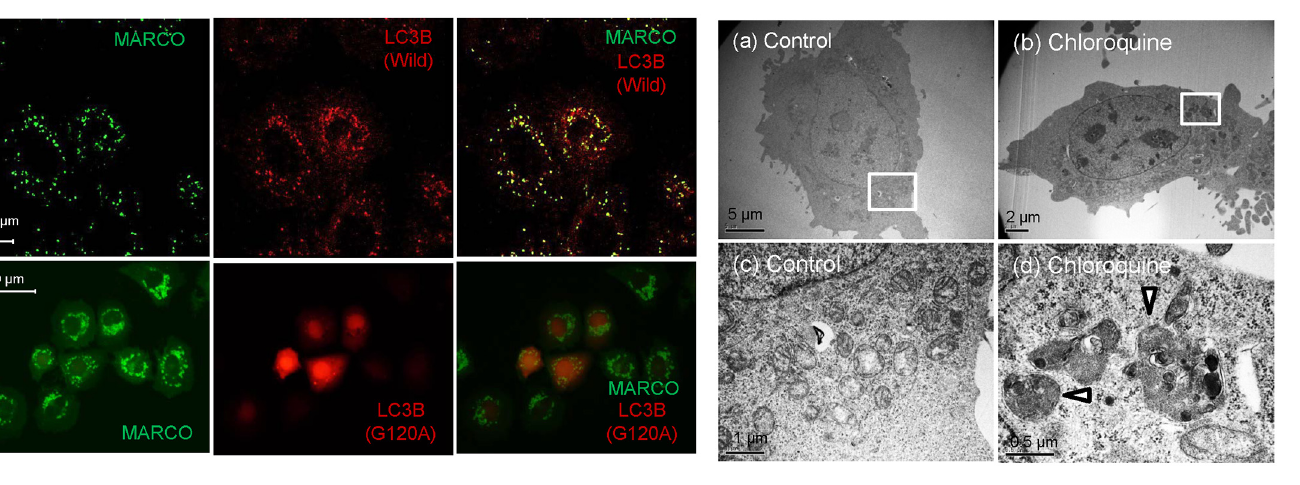
Fig 3. Effects of chloroquine on fluorescent puncta formation in GFP-MARCO-CHO cells. (A) Co-localization of green fluorescent puncta with LC3B. GFP-MARCO-CHO cells were transfected with constructs encoding LC3B (wild-type or G120A mutant), pre-cultured overnight in F12 complete medium, and further cultured for 16 hr in F12 complete medium supplemented with 50 μ M chloroquine. (B) Transmission electron micrographs of GFP- MARCO-CHO cells. The cells were cultured for 6 hr with (b, d) or without (a, c) 50 μ M chloroquine. Fig 3B(c) and (d) provide higher magnification images of the boxed areas in (a) and (b), respectively. The arrowheads indicate